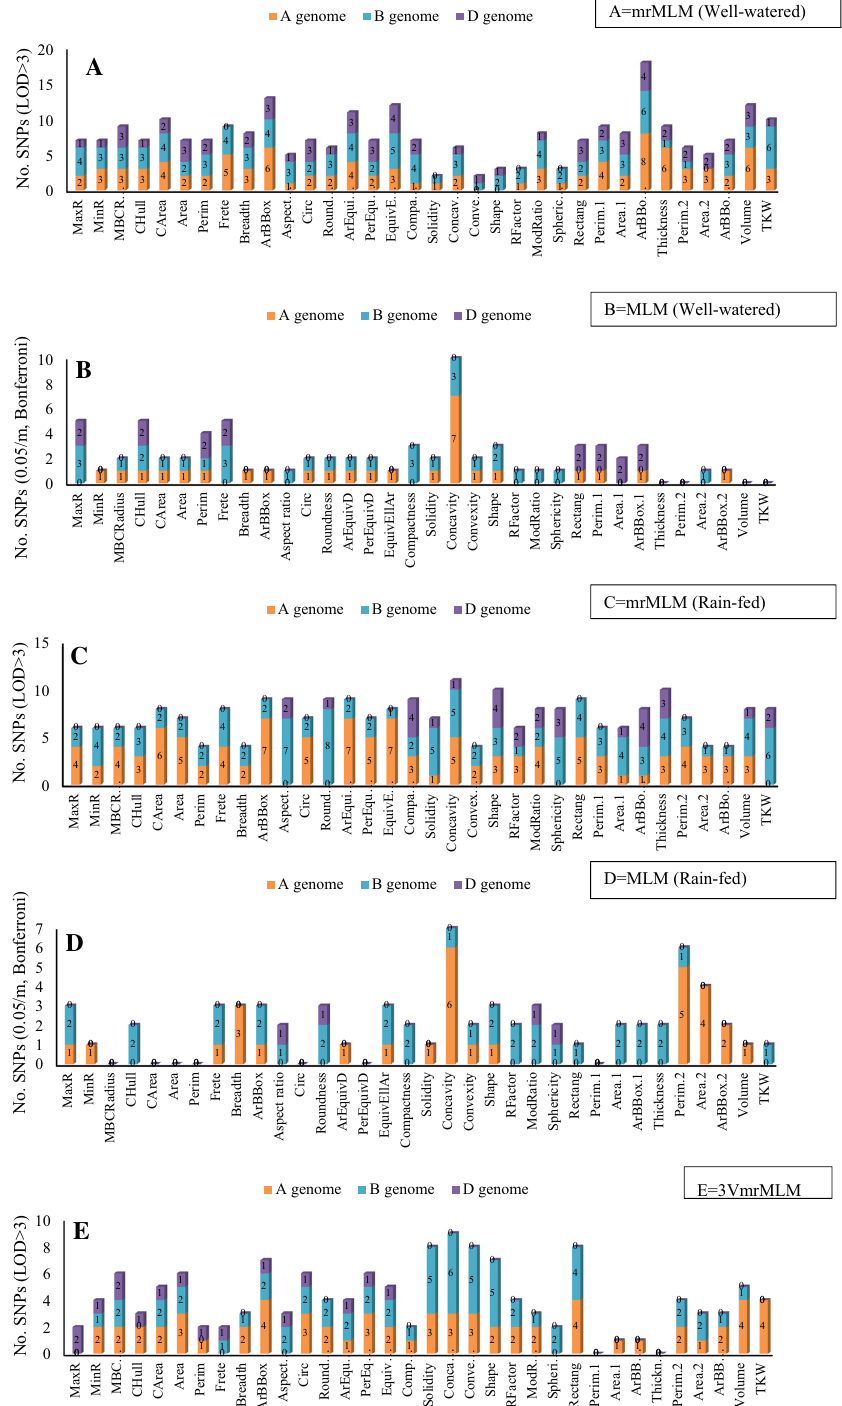
Figure 5. GWAS results for seed traits in Iranian wheat landraces and cultivars. ( A ) mrMLM (Well-watered), ( B ) MLM (Well-watered), ( C ) mrMLM (Rain-fed), ( D ) MLM (Rain-fed), ( E )